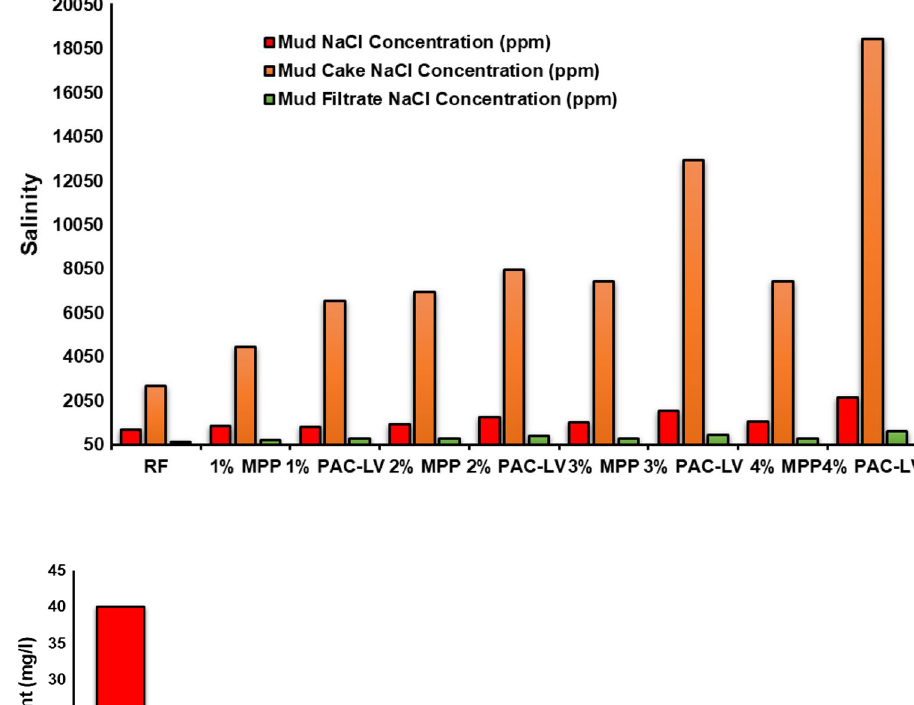
Fig. 13 The effect of MPP and